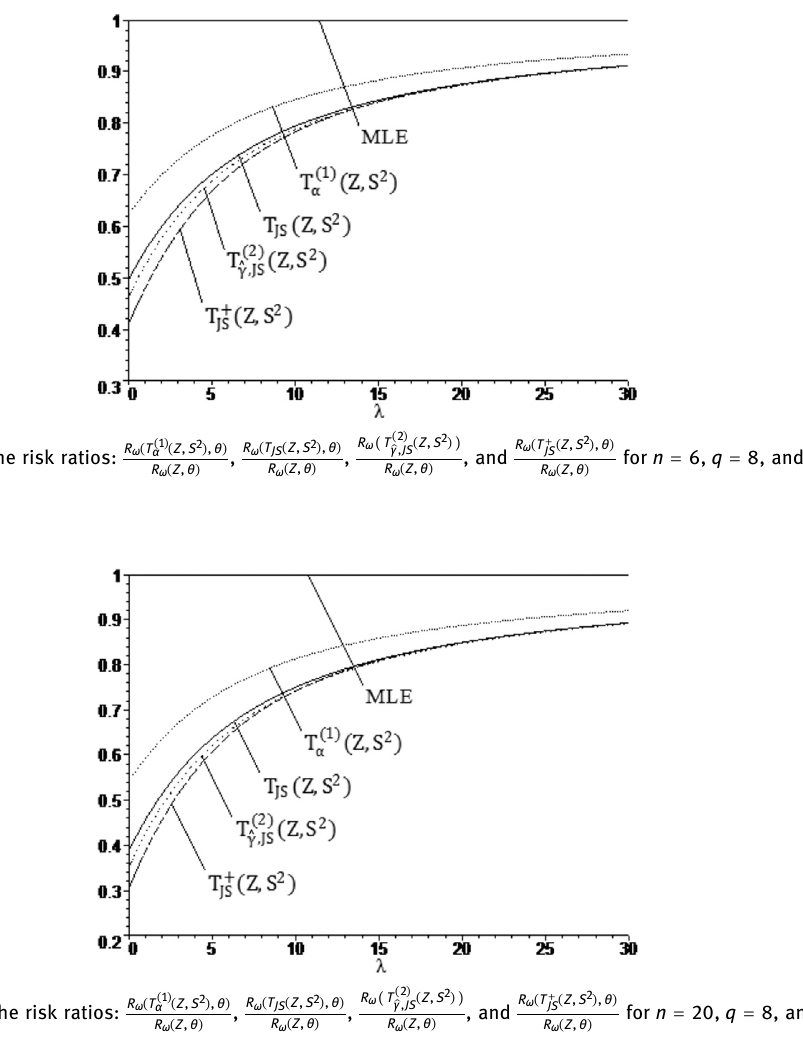
Figure 2: Curves of the risk ratios: R T Z S θ